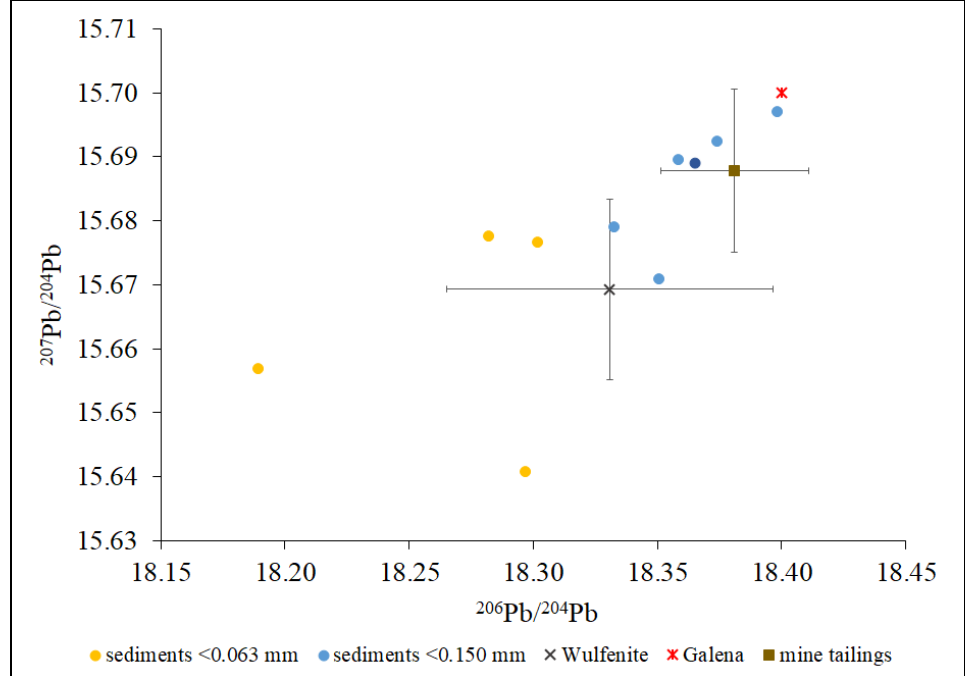
Figure 4. Pb isotope compositions of two sediment fractions (<0.063 and <0.150 mm) from the Meža River and its tributaries on a biplot of 207 Pb/ 204 Pb with 206 Pb/ 204 Pb. The dark blue circle marker for sediments <0.150 mm represents the sample from Črna 2, with fraction <0.250 mm. Values for mine tailings and wulfenite are from our unpublished data, and the value for galena is from Miler and Gosar [39].